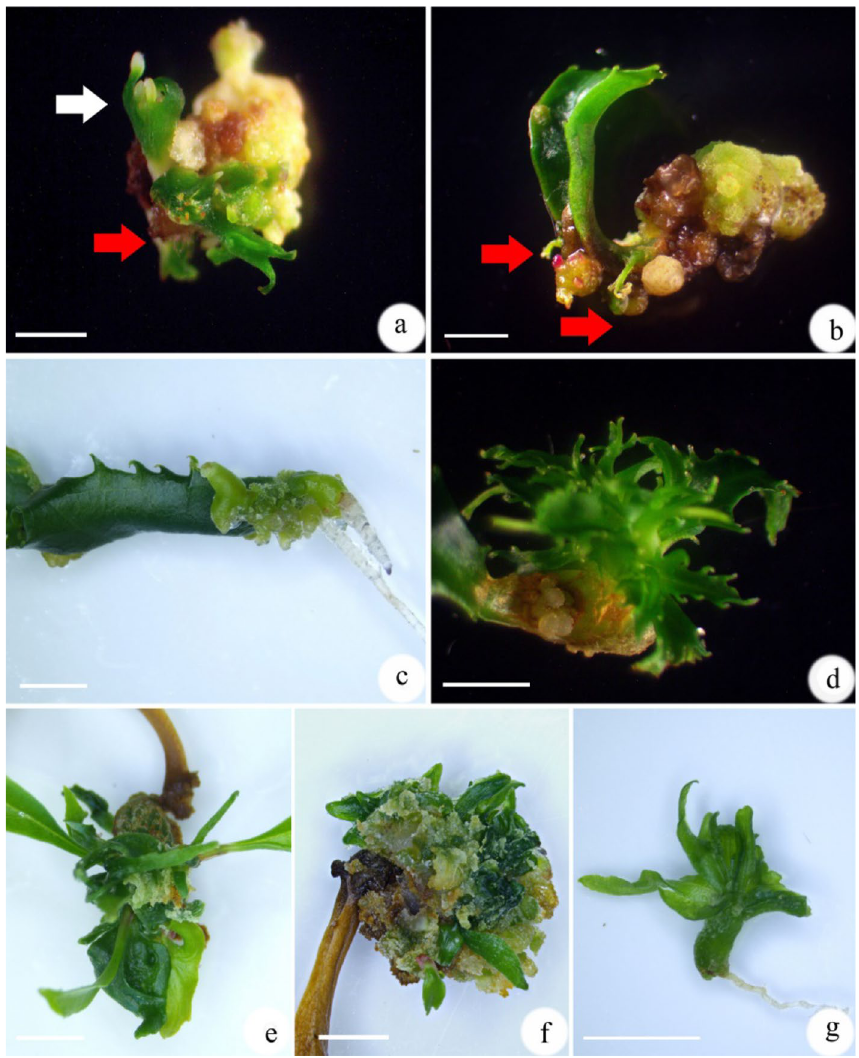
Figure 2. Shoot organogenesis from petiole explants of Euryodendron excelsum . ( a ) Callus induced on WPM with 1.0 mg/L 2,4-D after culture for 6 weeks, then differentiated into adventitious shoots (red arrow) and somatic embryo-like structure (white arrow) on PGR-free WPM for 3 weeks. ( b ) Adventitious shoots were induced on WPM with 1.0 mg/L TDZ after culture for 6 weeks. ( c ) Adventitious roots induced on WPM with 1.0 mg/L NAA after culture for 6 weeks. ( d ) Adventitious shoots induced on WPM with 1.0 mg/L BA after culture for 6 weeks. ( e ) A few adventitious shoots were induced on WPM with 1.0 mg/L KIN after culture for 6 weeks. ( f ) Fragile callus and somatic embryos induced on WPM with 1.0 mg/L zeatin after culture for 6 weeks. ( g ) A somatic embryos that was isolated from a callus clump derived from a petiole cultured on WPM with 1.0 mg/L zeatin for 6 weeks was transferred to WPM with 0.2 mg/L NAA for 3 weeks. Bars = 1.0